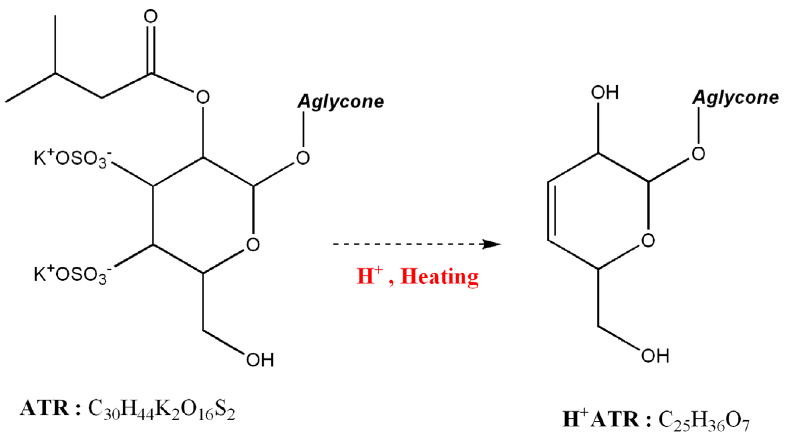
Figure 5. The degradation mechanism of ATR salt by acidification and